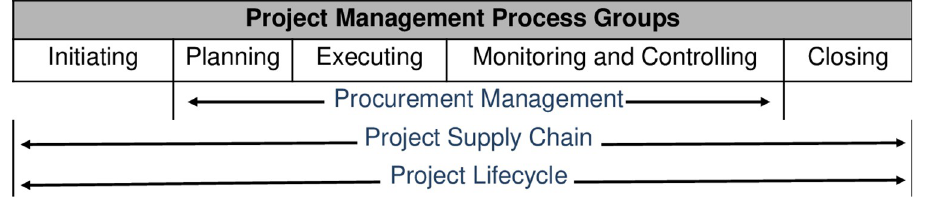
Fig 1. Project supply chain and the project life